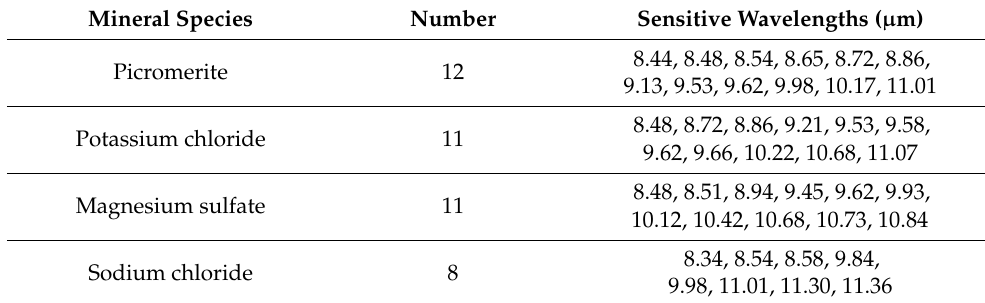
Table 6. CARS sensitive wavelengths screening